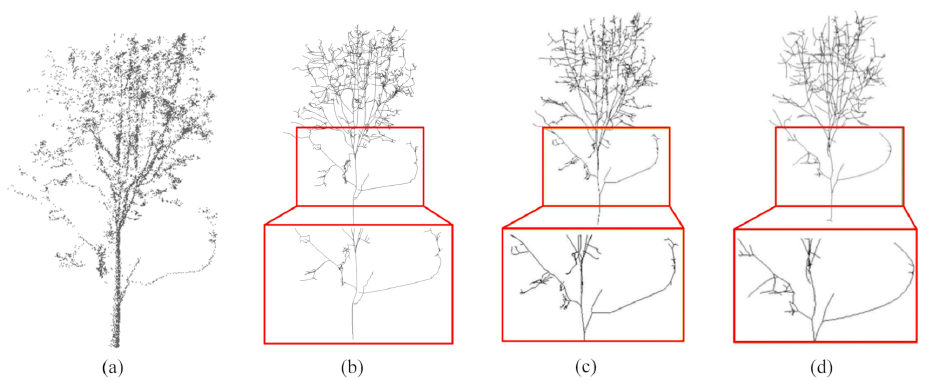
Figure 11. Comparison of Ginkgo biloba tree point cloud restoration and skeleton extraction results. ( a ) Tree point clouds; ( b ) Our method; ( c ) The method of Livny; ( d ) The method of